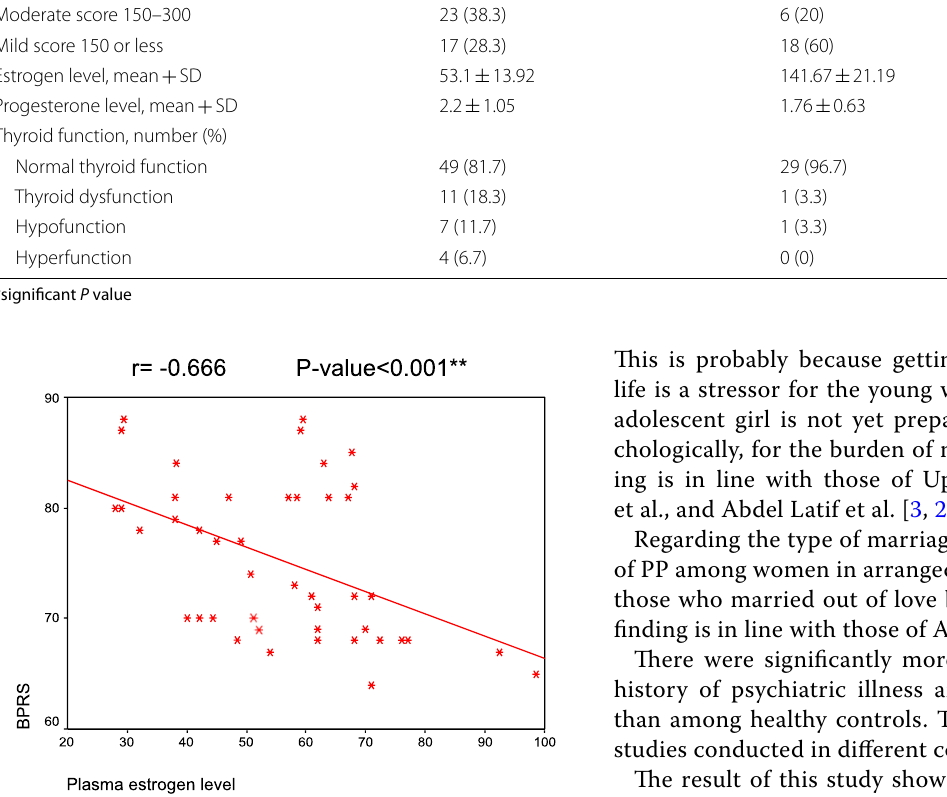
Fig. 1 Correlation between plasma estrogen level and BPRS in patients with postpartum